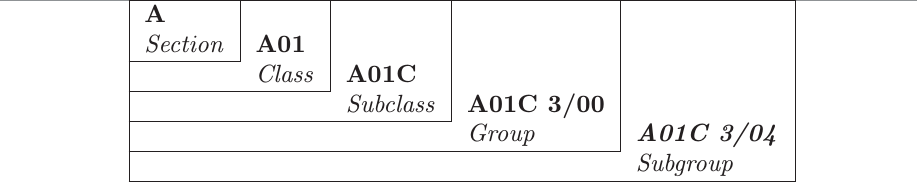
Table 1. International Patent Classification (IPC) scheme for a generic patent classified as A01C 3/04 .